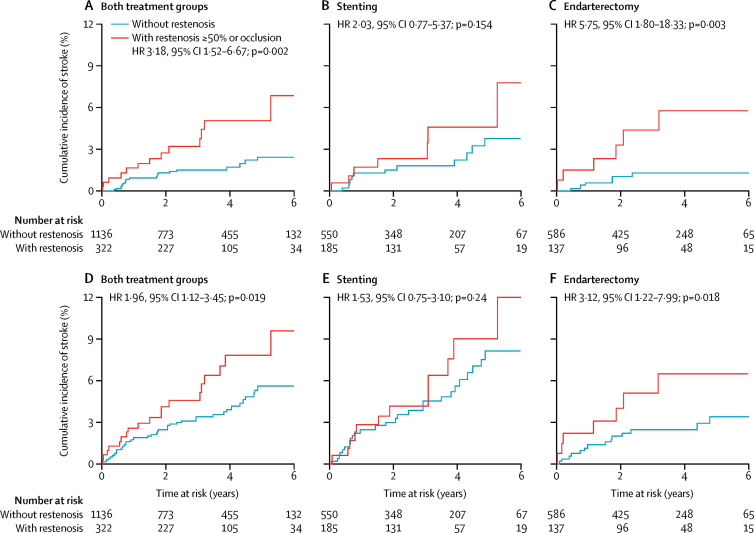
Kaplan-Meier curves of time to (A–C) ipsilateral stroke and (D–F) stroke in any territory with and without at least moderate (≥50%) carotid artery restenosis or occlusionHR=unadjusted hazard ratio.